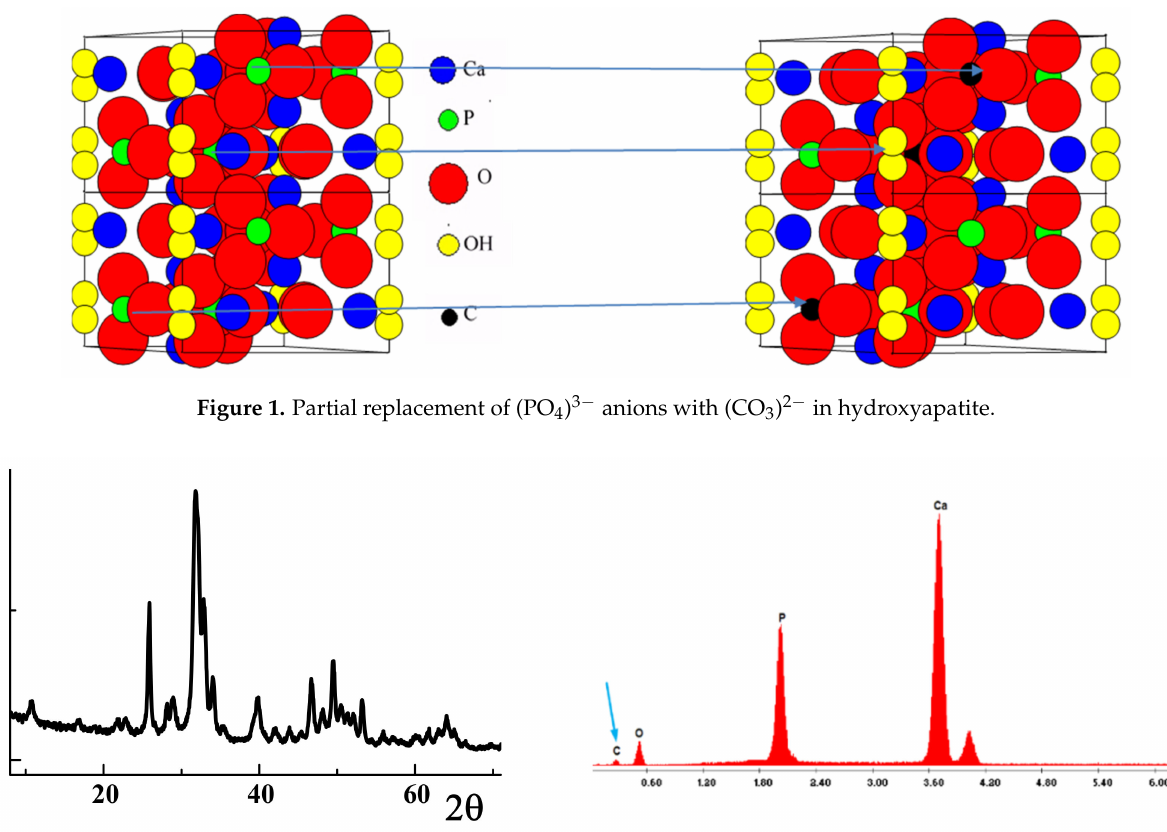
Ca 10 (CO 3 ) 0.85 (PO 4 ) 5.43 (OH) 2.1 , with a Ca/P atomic ratio of 1.85. This corresponded well with the results of EDAX analysis.